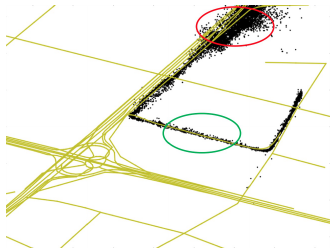
Figure 3. GPS trajectory data of one bus on different